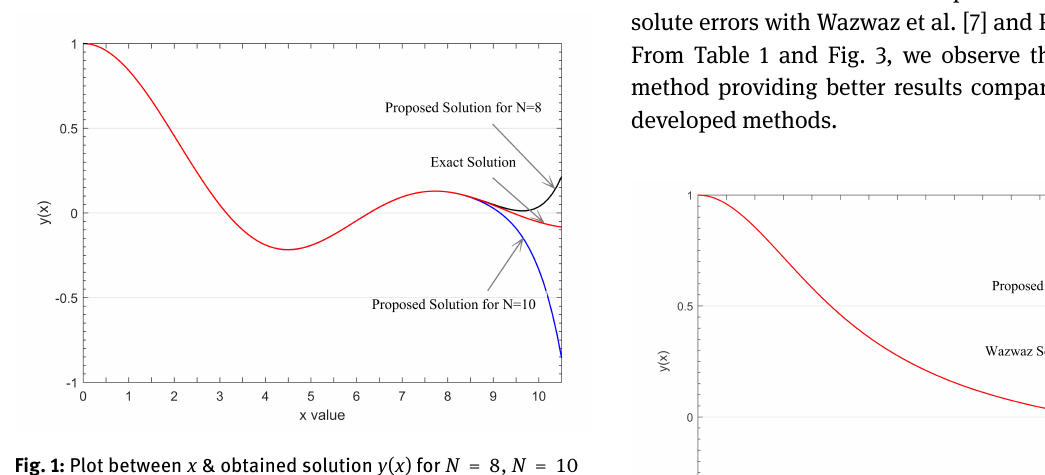
Fig. 1: Plot between x & obtained solution y ( x ) for N = 8, N = 10 and exact solution.